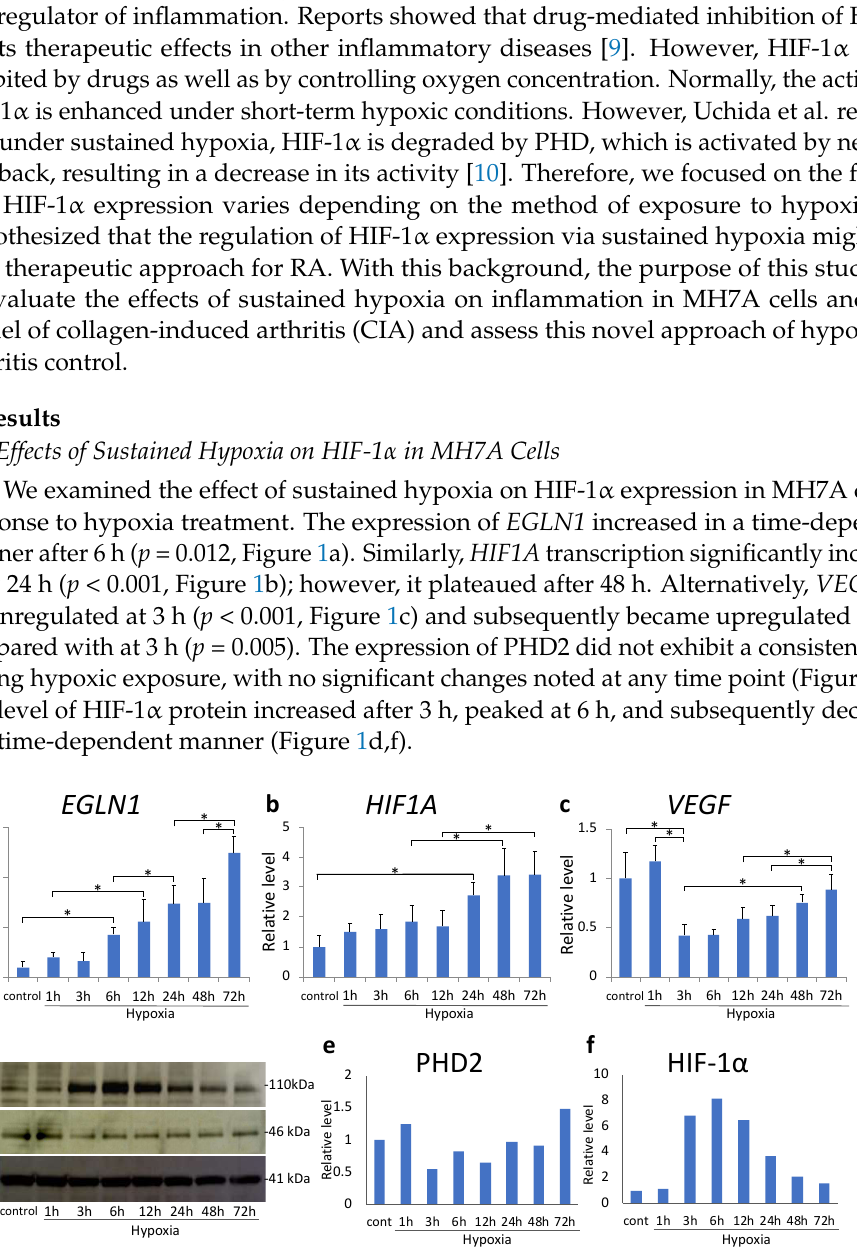
Figure 1. ( a–c ) EGLN1 ( a ), hypoxia inducible factor (HIF) -1α ( b ), and VEGF ( c ) mRNA levels in MH7A cells were analyzed using quantitative reverse-transcription polymerase chain reaction (RT–PCR) after 72 h of hypoxia (1% O 2 ). Each value represents the mean ± SD. (n = 6); *p < 0.05. ( d– f ) Prolyl hydroxylase domain-containing protein 2 (PHD2) and HIF-1α protein expression was analyzed using Western blotting; β -actin was used as the loading